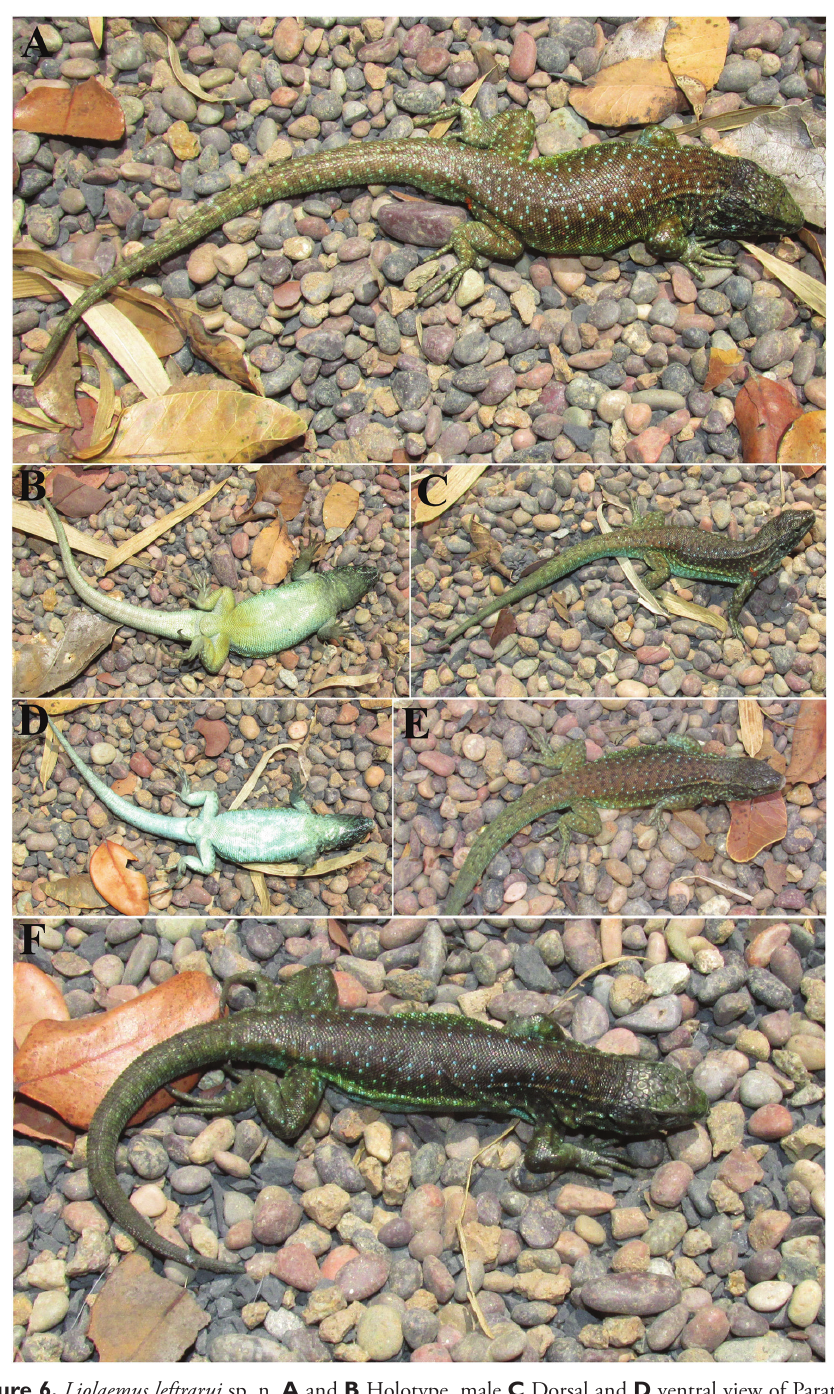
Figure 6. Liolaemus leftrarui sp. n. A and B Holotype, male C Dorsal and D ventral view of Paratype, female E and F Paratypes,